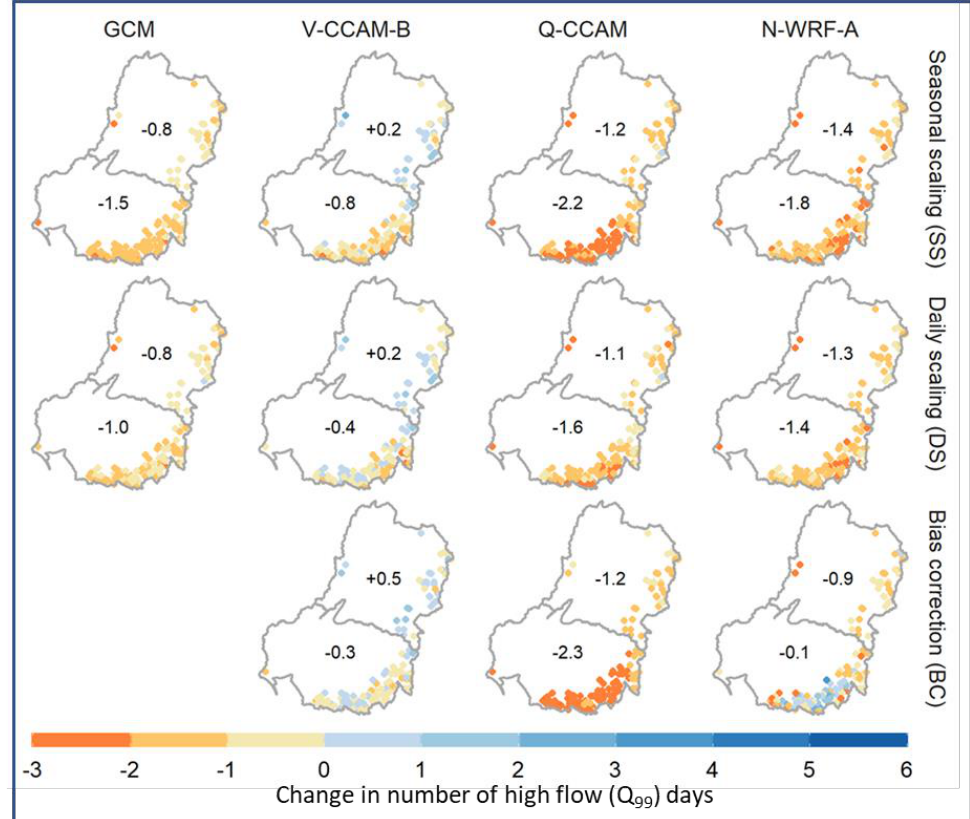
Figure 4. Median value of modelled change in future high flow days across the 133 catchments from each of the different climate projection products and methods used to generate future daily rainfall series (the numbers in the map show the average of the median values in all the catchments in the northern MDB and the southern MBD).